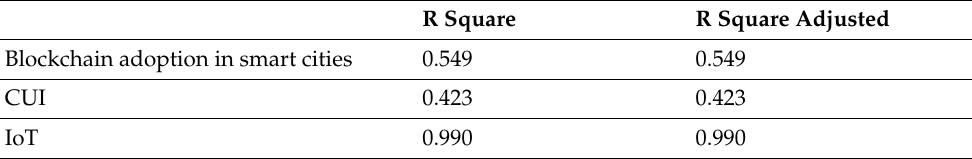
Table 1. R2 in Structural Model.